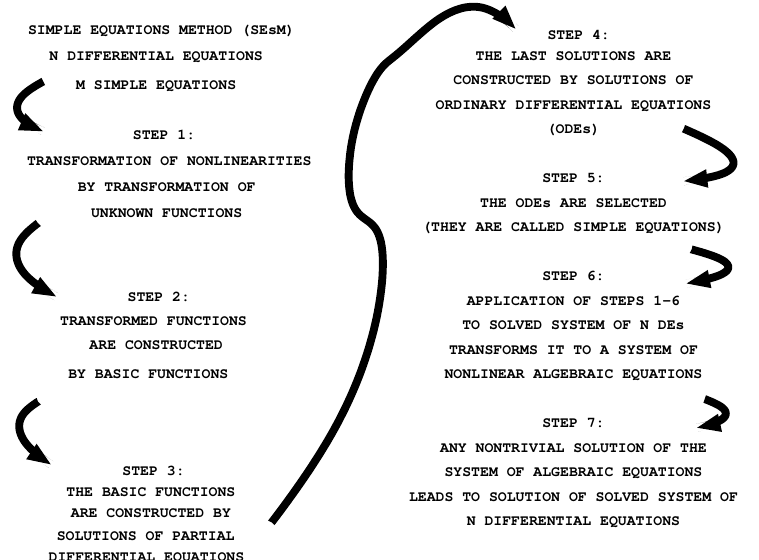
Figure 2. The 7 steps in the case of the SEsM from [47]. For details, see [47].